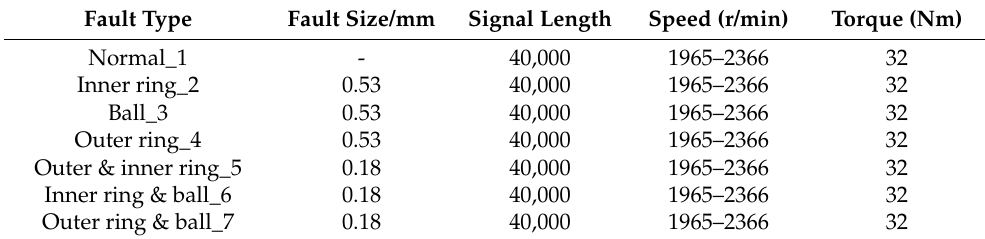
Figure 6. Acceleration sensor LMS acquisition front end and real-time data feedback. Table 2. Description of experimental data set.